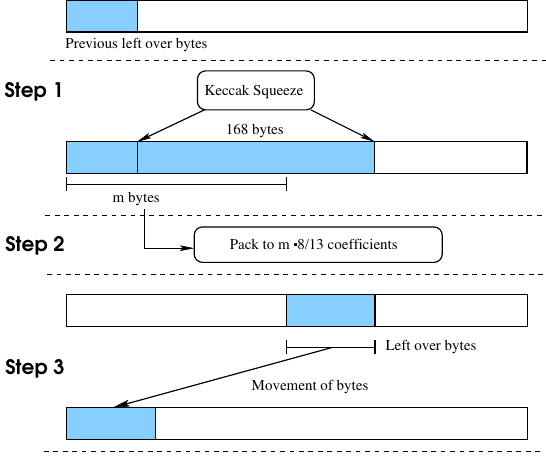
Figure 2: Use of byte-bank during generation of polynomials of AAA . Turquoise blue color is used to indicate the bytes that will be